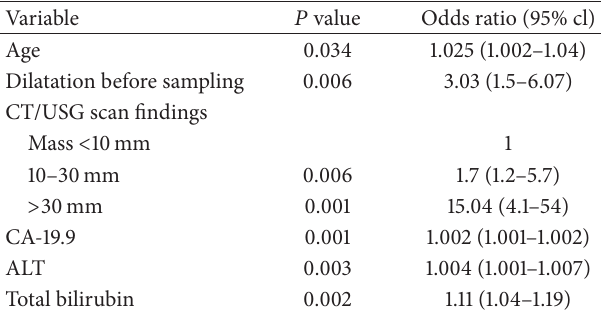
Table 4: Independent predictors of positive brush cytology. Table 5: Tumor markers in malignant and benign